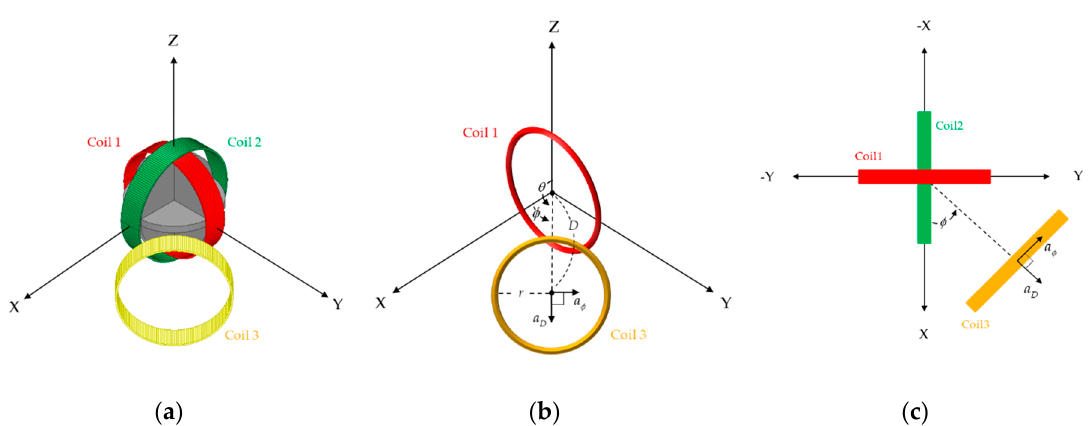
Figure 3. System model for deriving mutual inductance between transmitter and receiver: ( a ) System configuration; ( b ) deriving mutual inductance between coil 1 and coil 3; ( c ) deriving mutual inductance between coil 2 and coil 3.